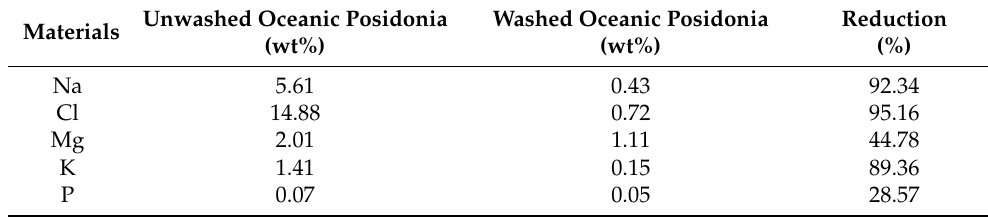
Table 2. X-ray fluorescence results before and after Posidonia oceanica washing.